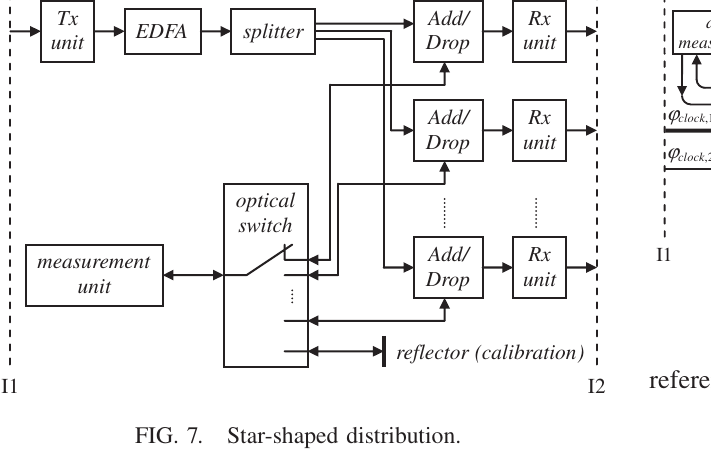
FIG. 7. Star-shaped